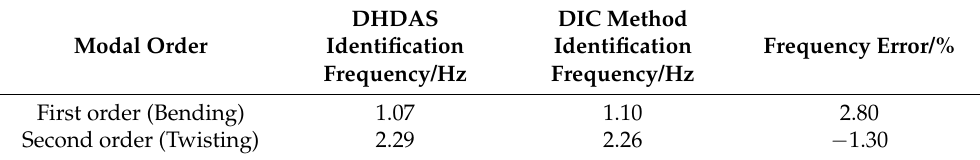
Table 2. Comparison of modal parameter recognition results.